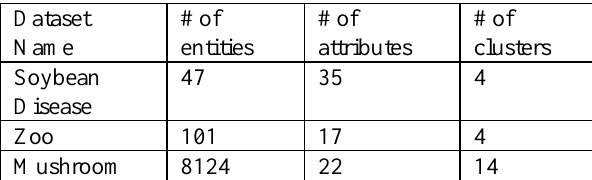
Table 3: Characteristics of datasets